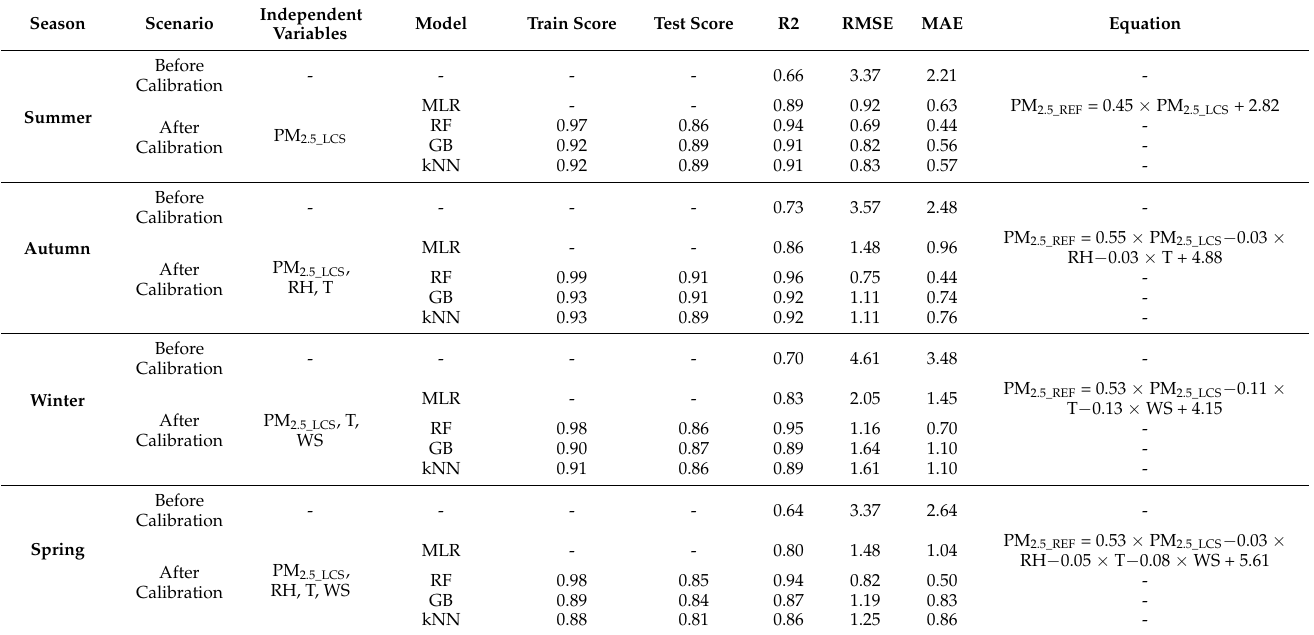
Table 2. Season-wise calibration of PM 2.5_REF with PM 2.5_LCS